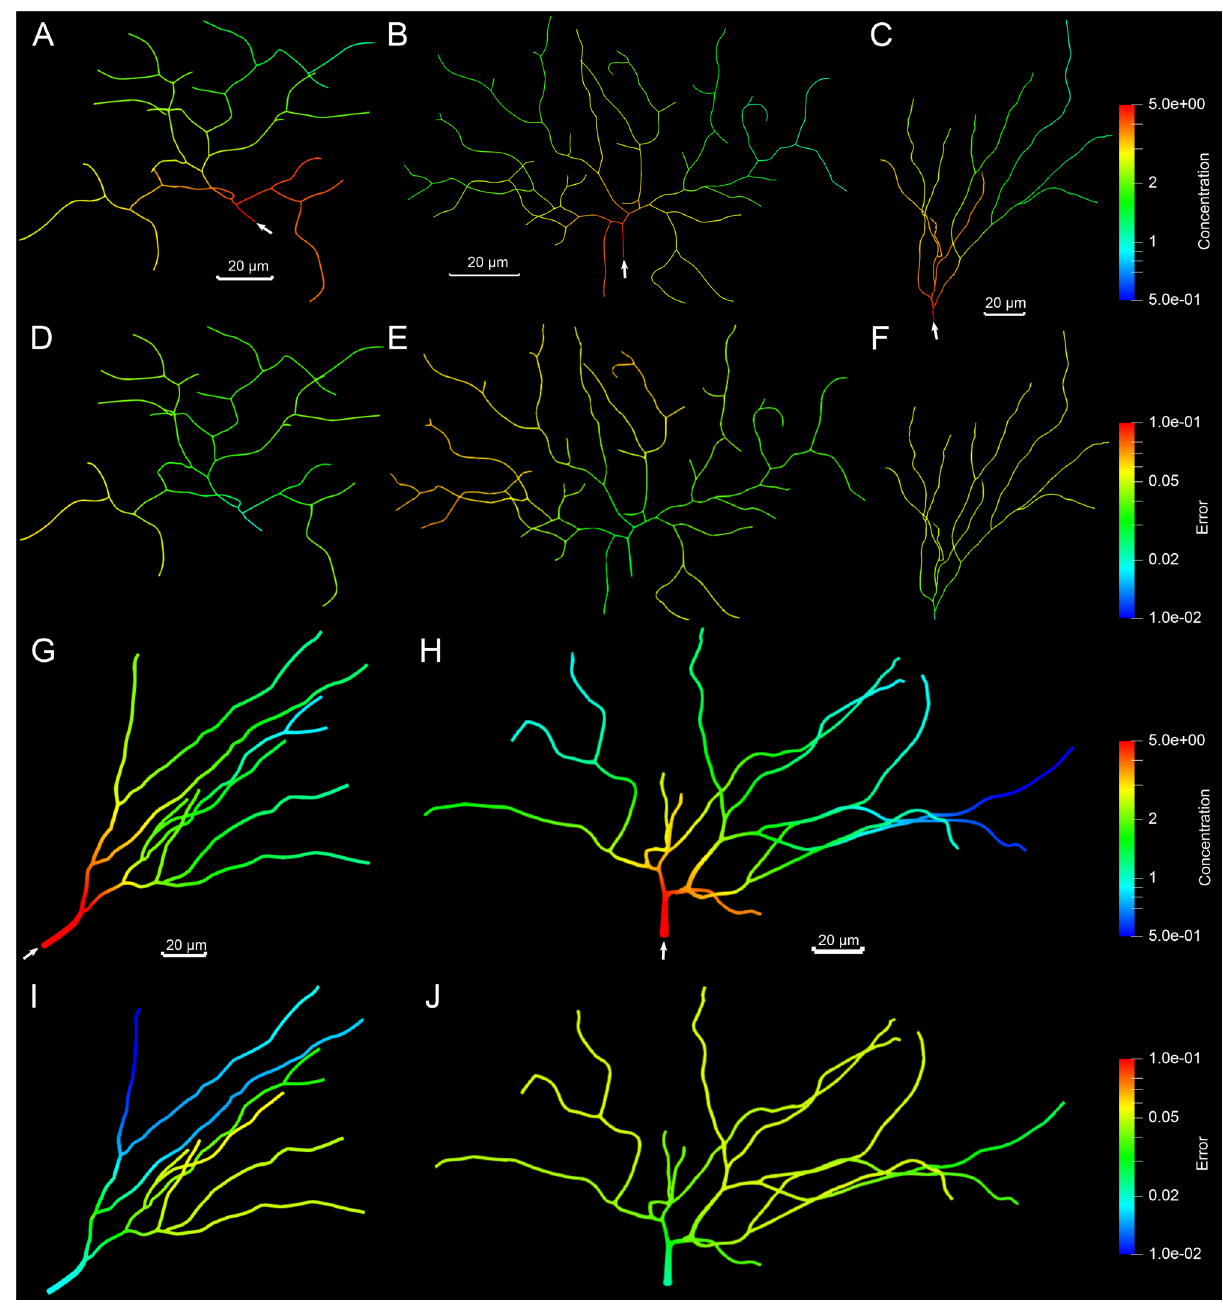
Figure 4. The concentration prediction of material transport in the neurite network geometry of NMO_06846, NMO_06840, NMO_112145, NMO_32235 and NMO_32280. ( A – C , G , H ) The predicted concentration results of steady state at t = 15 s , 26 s , 19 s , 28 s and 32 s , respectively. The white arrows point to the inlet of material. 3 Scalar bar: 20 µ m . Unit for color bars: mol /µ m . ( D – F , I , J ) The nodal errors between the ground truth and predicted concentration. Logarithmic scale is used to highlight the distribution